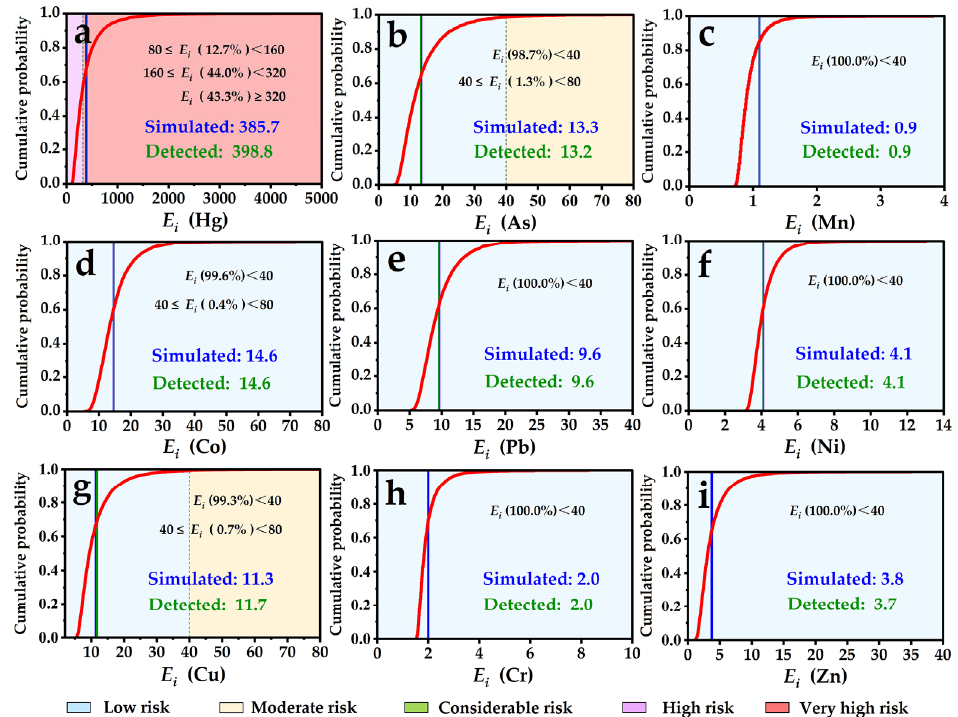
Figure 2. Cumulative probability distribution of the modified ecological risk factor ( E i ) in the RSD based on MCS. ( a ) E i (Hg); ( b ) E i (As); ( c ) E i (Mn); ( d ) E i (Co); ( e ) E i (Pb); ( f ) E i (Ni); ( g ) E i (Cu); ( h ) E i (Cr); ( i ) E i (Zn).